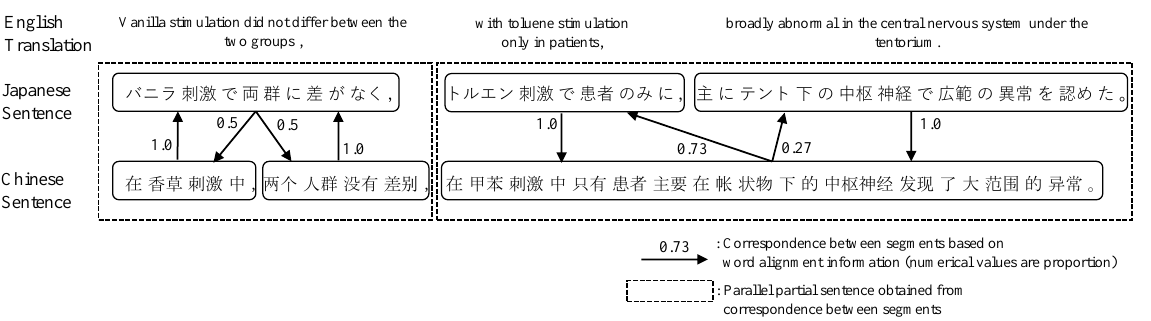
Figure 1. Example of word alignment information and sentence segments by punctuation marks.